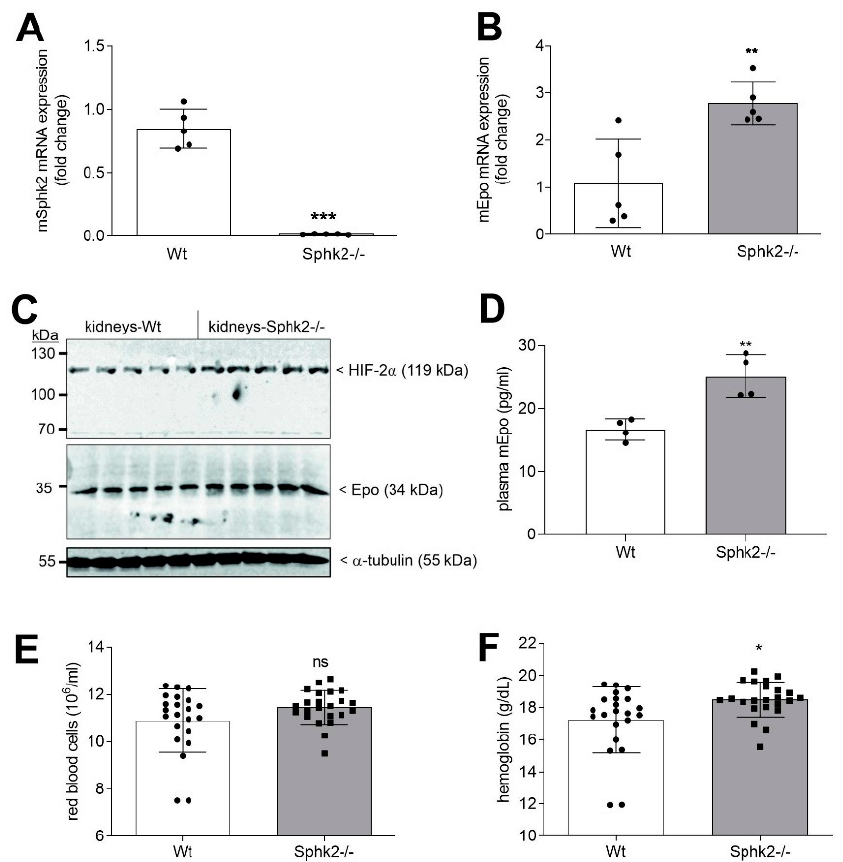
Figure 7. Epo mRNA and protein levels in kidneys from Wt and Sphk2 − / − mice under normoxic conditions. Kidneys from C57BL/6 (Wt) mice and Sphk2 − / − mice were taken for RNA ( A , B ) or protein ( C ) extraction. mRNA was analyzed by qPCR using primers for mSphk2 ( A ) and mEpo ( B ), and mL28 mRNA for normalization. ∆∆ Ct values were calculated and results show the fold change compared to the Wt controls and are means ± S.D. ( n = 5), ** p < 0.01, *** p < 0.001 considered statistically significant when compared to the Wt control samples. ( C ) Protein was analyzed by immunoblotting using antibodies against HIF-2 α (top panel), Epo (middle panel), and α -tubulin (bottom panel). Corresponding bands were evaluated by Image Studio Lite software (version 3.1, LI-COR Biosciences, Lincoln, NE, USA), normalized to α -tubulin, and are presented in Figure S11. ( D ) Blood was collected from Wt or Sphk2 − / − mice and plasma Epo was quantified by ELISA. Results are depicted in pg/mL and are means ± S.D. ( n = 4), ** p < 0.01 was considered statistically significant when compared to the Wt samples. ( E , F ) Blood from Wt and Sphk2 − / − mice was analyzed for the number of red blood cells ( E ) and hemoglobin ( F ) as described in Section 4. Results are means ± S.D. ( n = 22 for Wt and 23 for Sphk2 − / − ). * p < 0.05 compared to the Wt mice. In a final approach, we aimed to confirm our results in an independent human cell line. Hep3B hepatoma cells are well-established to induce Epo under hypoxic conditions [55]. A stable hSphk2 knockdown was established in Hep3B cells as shown by the 80% reduction of hSphk2 mRNA (Figure 8A). Exposure of control Hep3B cells for 6 h to hypoxia, induced HIF-2 α stabilization (Figure 8C, top panel) and enhanced Epo mRNA (Figure 8B) and protein levels (Figure 8C, middle panel). In contrast, in hSphk2-kd cells, HIF-2 α and Epo was increased under hypoxia as compared to control cells (Figure 8C). A similar effect was seen on Epo mRNA level (Figure